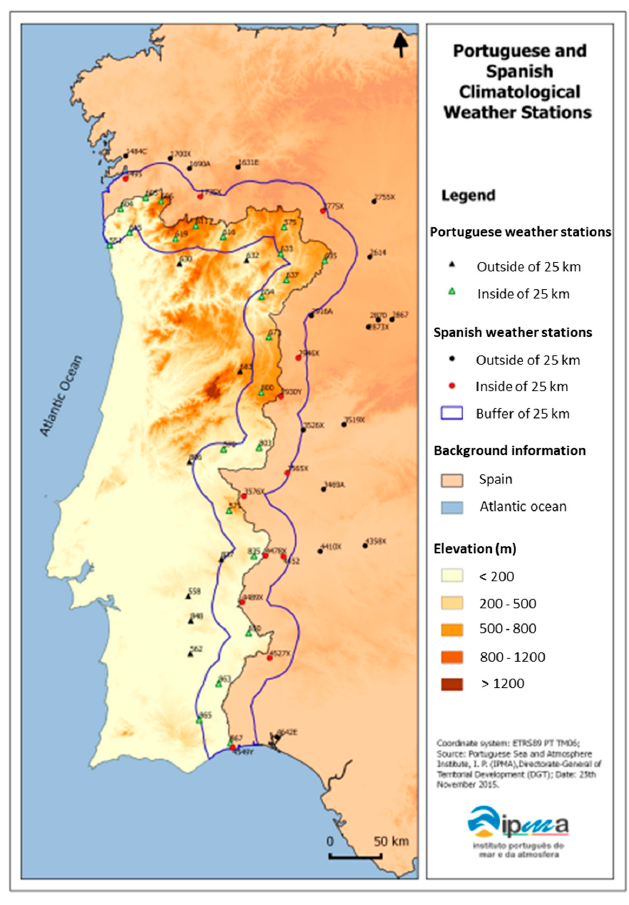
Figure 2 . Area of interest (25 km for each side of the transboundary strip between Portugal and Spain) and available climatological weather stations.